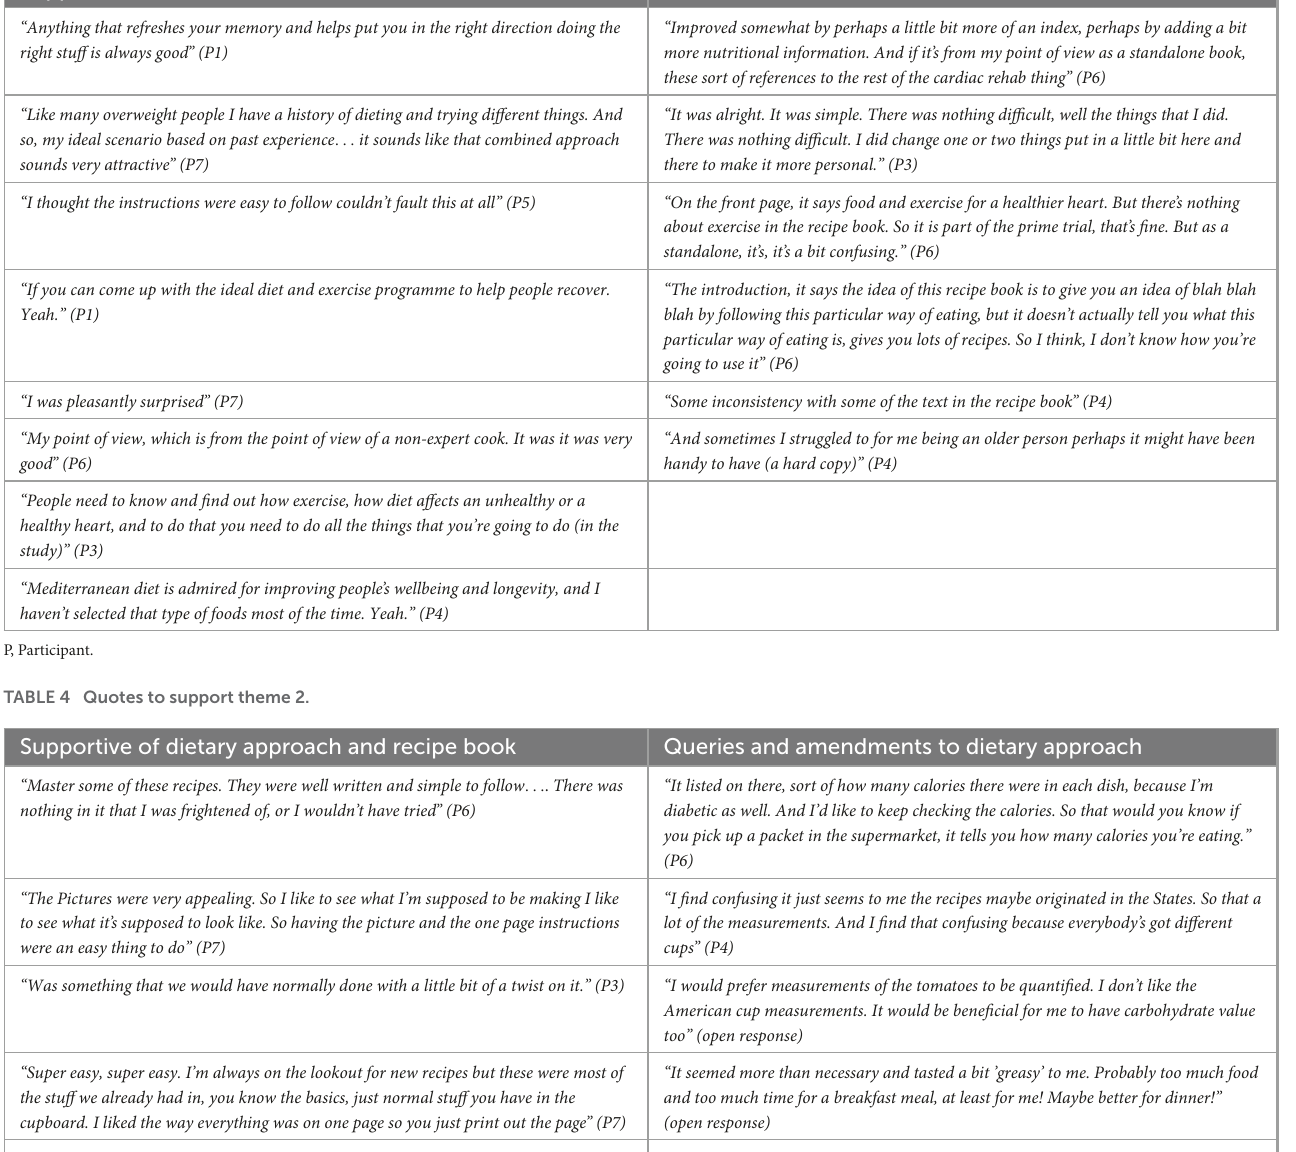
TABLE 3 Quotes to support theme 1.